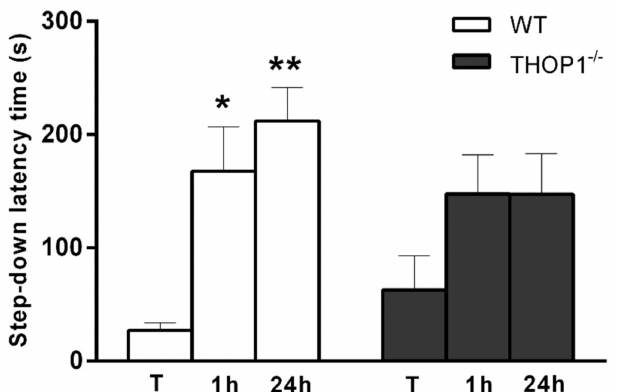
Figure 8. Step-down passive avoidance task: in this task, the time the animal takes to step-o ff from the platform (step-o ff latency) was determined. The longer the mouse stays on the platform. the greater was the latency for step-o ff . indicating that the mouse learned the passive avoidance task. WT showed higher latency to step-down during tests as compared to training. THOP - / - showed an impairment of memory retention at training-tests. Results are expressed as mean ± S.E.M. Statistical significance was determined by two-way ANOVA test. Sidak’s post hoc: * p < 0.05 between WT training (T) and WT 1 h test; ** p < 0.01 between WT training (T) and WT 24 h test; No statistically significant di ff erences were observed for the THOP1 - / - mice between training and 1 h or 24 h tests. WT. n = 10; THOP1 - / - . n =